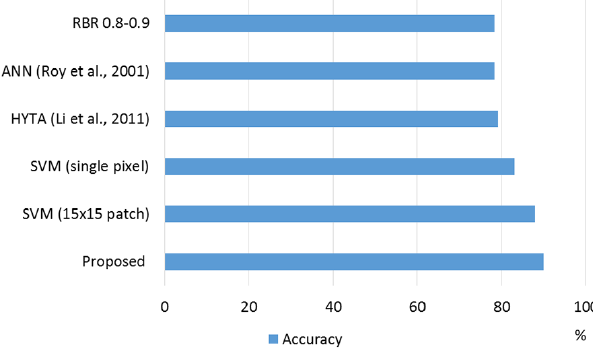
Figure 8. Detection accuracy using different number of levels.